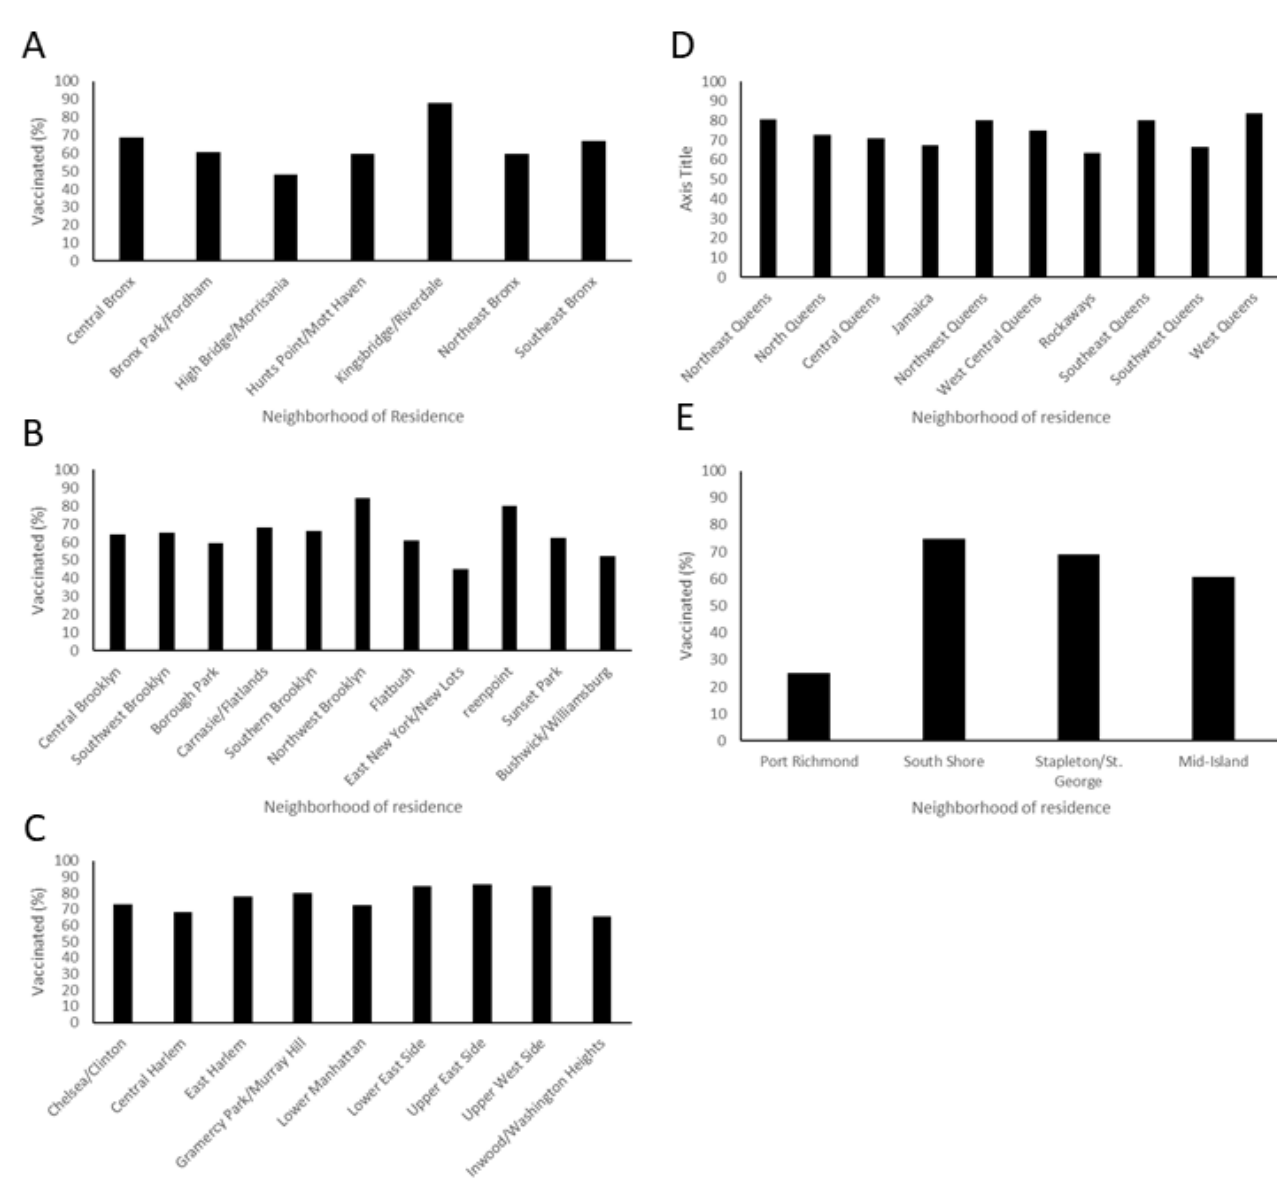
Figure 2. Neighborhoods within boroughs show different vaccination rates between health pro- fessionals who live there . ( A ) Vaccination rates in the Bronx are significantly different based on neighborhood ( p < 0.001, n = 479) and range from 87.75% to 48.33%. ( B ) Vaccination rates for health professionals in Brooklyn are dependent on neighborhood ( p = 0.00028 n = 762). Vaccination rates in Brooklyn range from 45.24% to 84.62%. ( C ) Manhattan has overall high vaccination rates but they are significantly dependent on neighborhoods ( p = 0.0169 n = 593). Health professionals vaccinated in Manhattan range from 65.57% to 85.59%. ( D ) Queens was more homogenous in HCW vaccination rate by neighborhood, with no overall significant difference found ( n = 624). Rates in Queens range from 63.33% to 83.63%. ( E ) Staten Island vaccination rates significantly differed by neighborhood ( p = 0.022, n =